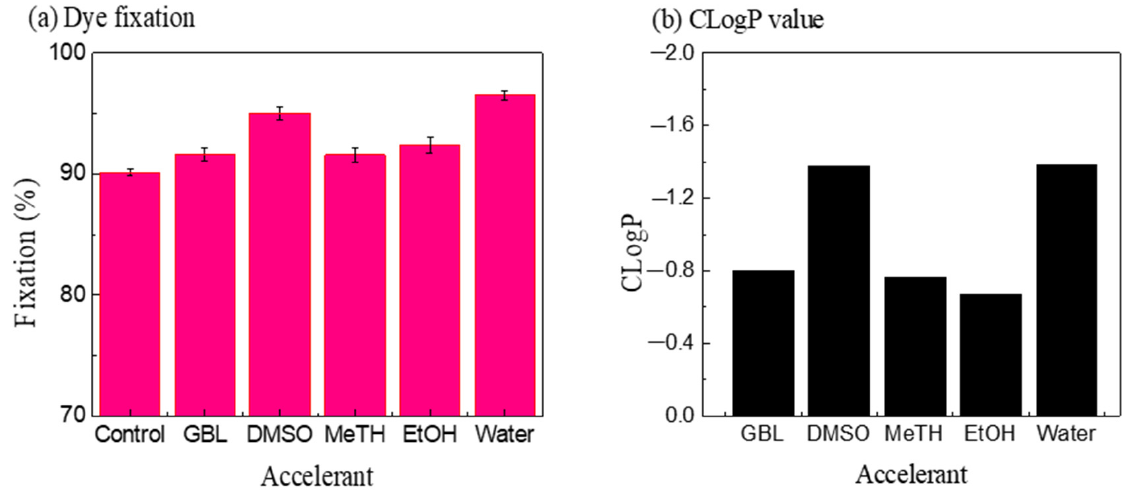
Figure 7. The relationship between the exhaustion of dye ( a ) and CLogP values of chemicals ( b ).